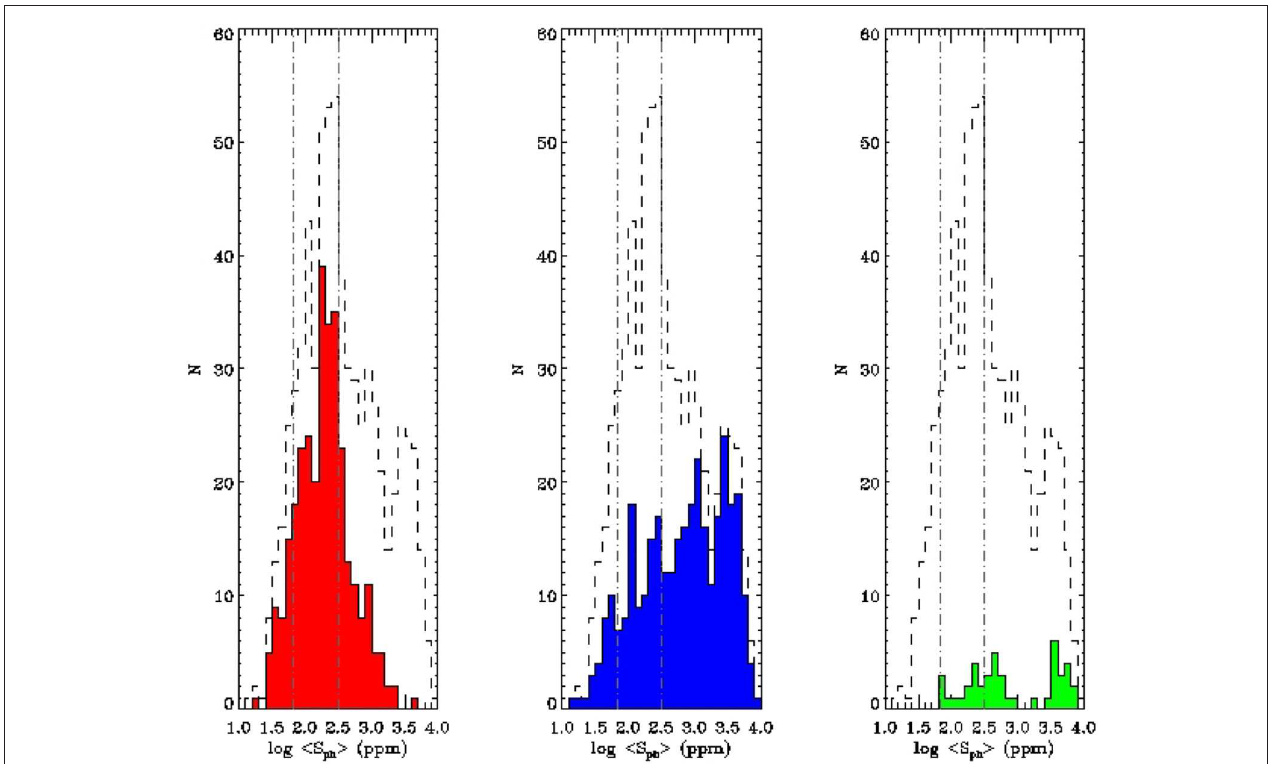
FIGURE 6 | Distribution of the < S ph > for the full sample and the three categories of stars as described in section 4. Same legend as Figure 5 . The gray dashed-dotted lines represent the values at minimum and maximum magnetic activity for the